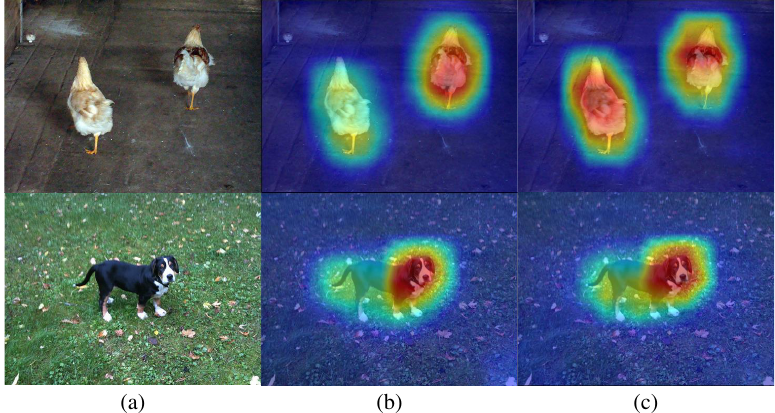
Figure 5. Visualization of Grad-CAM results based on ResNet-50; ( a ) original images; ( b ) ResNet-50; ( c ) ResNet-50 with